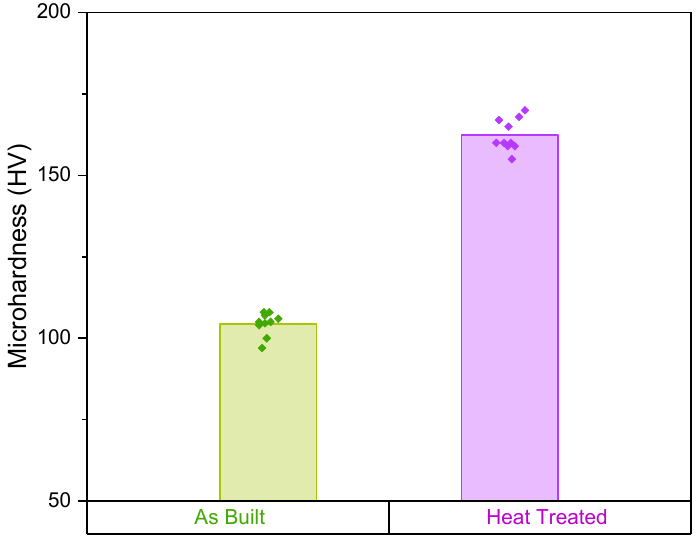
Figure 9. Results of microhardness Vickers analysis before and after heat treatment.